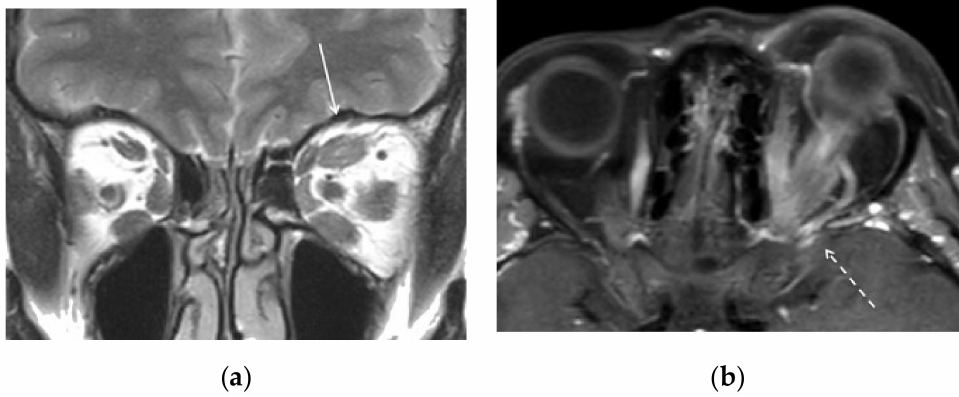
Figure 1. ( a ) MR, T2-weighted image, coronal plane, confirming a bilateral global hypertrophy of the extrinsic muscles, more pronounced to the left superior rectus (white arrow). ( b ) MR, T1-weighted fat- sat postgadolinium image, axial, showing a slightly enlarged left superior ophthalmic vein (dashed arrow), partially pinched by the superior rectus muscle.